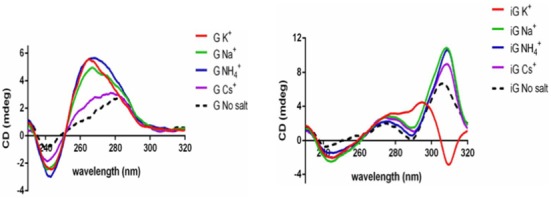
Circular dichroism (CD) spectra of the products of incubation of 5′-T8G4T (‘G’) and of 5′-T8iG4T (‘iG’), in buffered solutions containing, variously, 20 mM of NaCl, KCl, NH4Cl, CsCl or no added salt.